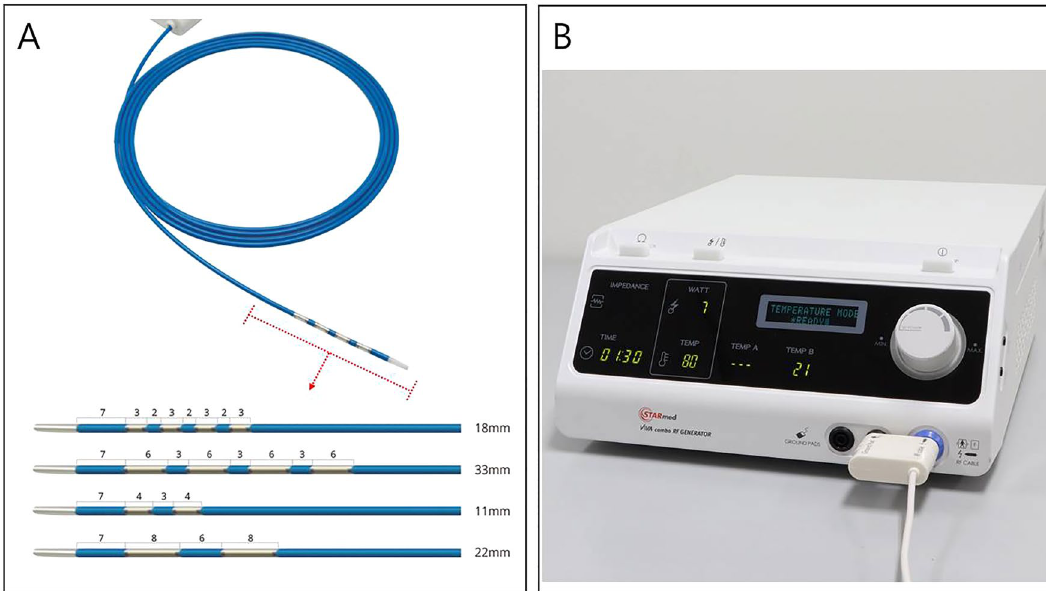
Figure 1. The endobiliary radiofrequency catheter (ELRA™ RF catheter, STARmed, Goyang, Korea) and power generator (VIVA Combo™; STARmed) used for endobiliary RFA (Courtesy of STARmed). ( A ) An endobiliary RFA catheter and the distal ends of different types of RFA catheters. Among them, the 7 ~ 10-W/22-mm type was used in this study. ( B ) The radiofrequency power generator and our